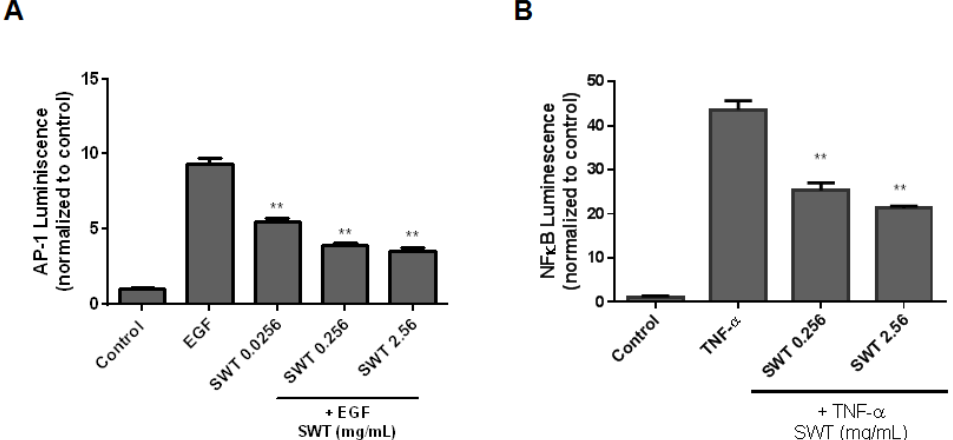
Figure 3. Effects of SWT on AP-1 and NF- κ B activation. ( A ) Luciferase assay using HEK-293 cells co-transfected with a plasmid containing an AP-1-luciferase reporter gene (pGL4.22-AP1) and a plasmid encoding renilla luciferase (pGL4.74). The transfected cells were treated with EGF (10 ng/mL) and SWT for 24 h prior to measurement of firefly and renilla luciferase activities using the dual luciferase reporter gene assay; and ( B ) luciferase assay using MCF-7 cells co-transfected with a plasmid containing an NF- κ B-luciferase reporter gene (pGL4.22-NF- κ B) and a plasmid encoding renilla luciferase (pGL4.74). The transfected cells were treated with TNF- α (20 ng/mL) and SWT for 5 h prior to measurement of firefly and renilla luciferase activities using the dual luciferase reporter gene assay. **: p < 0.01.